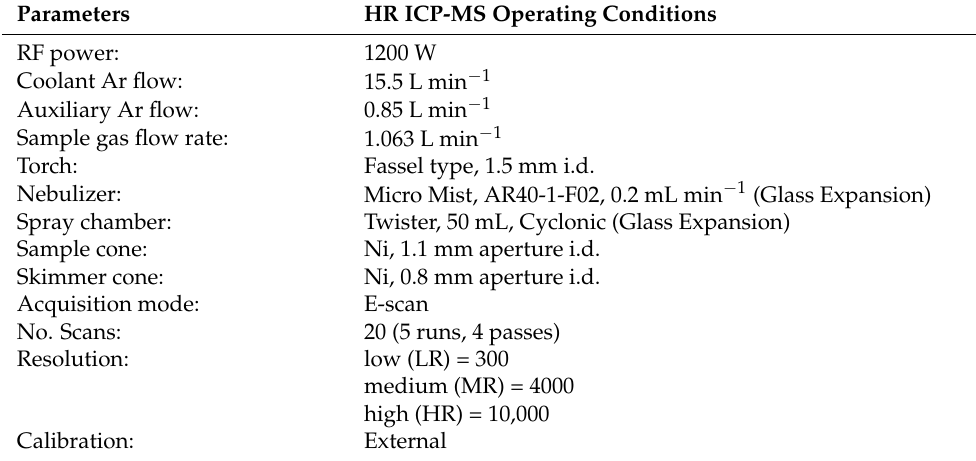
Table 1. Instrumental conditions of the HR ICP-MS and data acquisition parameters for determination of selected